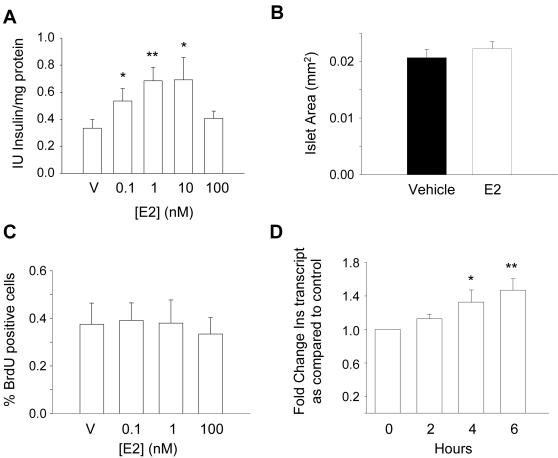
E2 action on insulin content, β-cell mass and insulin gene expression.(A) Insulin content of islets exposed to increasing doses of E2 for 48 hours, V means vehicle, (n = 8, 8 mice), * p<0.05, ** p<0.01, Mann-Whitney test, compared to vehicle. (B) Average size of islets cultured in the presence of vehicle (black column) or 1 nM E2 (white column) for 48 hours. Data represent the mean±SEM of at least 60 islets per condition obtained from 5 different animals. (C) Dispersed islet cells were counted under a fluorescent microscope and results are depicted as a percentage of BrdU-positive cells, values represent the mean±SEM of 4 independent experiments, each representing 3000 cells per condition. (D) Rat pancreatic islets were incubated for up to 6 hours in the presence of 10 nM E2. RNA was subsequently isolated and insulin as well as cyclophilin transcript levels were evaluated by quantitative RT-PCR. Data are presented as fold change of mRNA levels as compared to control untreated islets and normalized to the cyclophilin transcript. Values represent the mean±SEM of 3 independent experiments performed in duplicates. Statistical significance was tested by Student's t test. *, P<0.05; **, P<0.01.